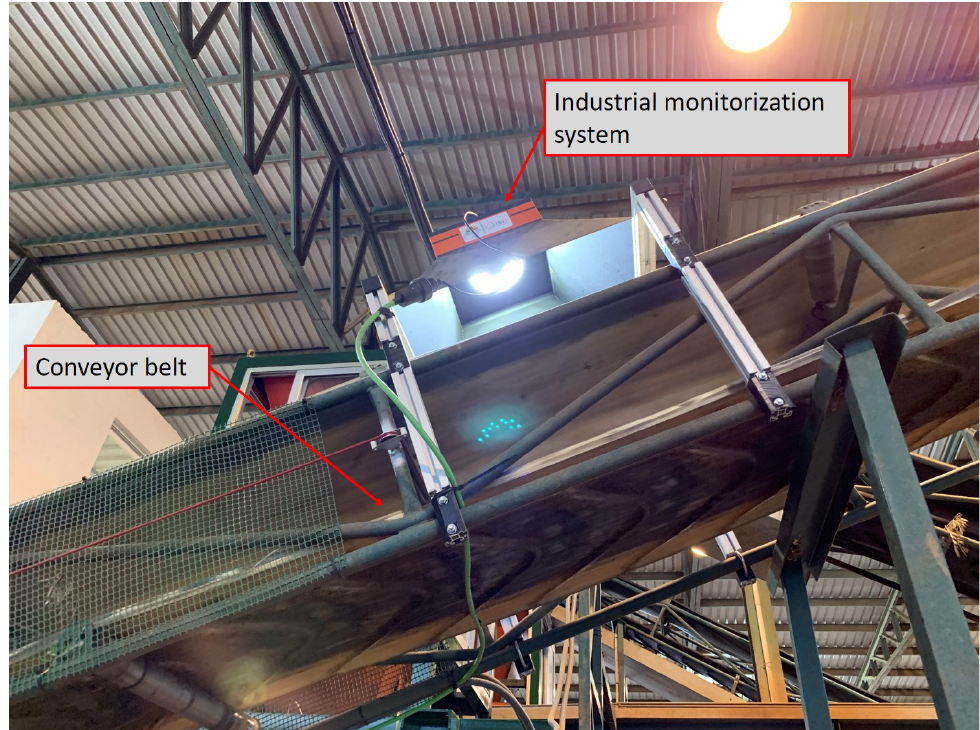
Figure 1. Industrial monitorization system installed on the conveyor belt after the olive cleaning